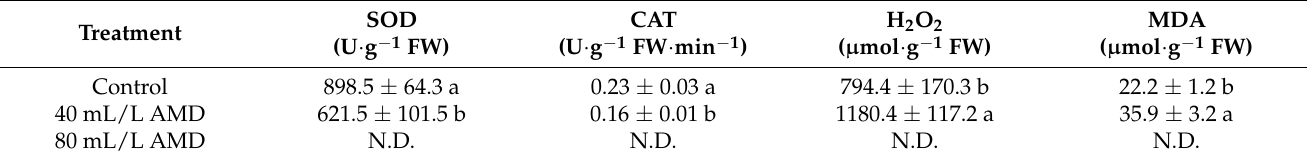
Table 1. Response of antioxidative systems of soybean seedlings to AMD after 7 days. (Different letters, a, and b, represent statistical differences between treatments; the error represents standard deviation; Fisher LSD multiple comparison; p < 0.05 level; N = 3; N.D. indicates no data). SOD Treatment